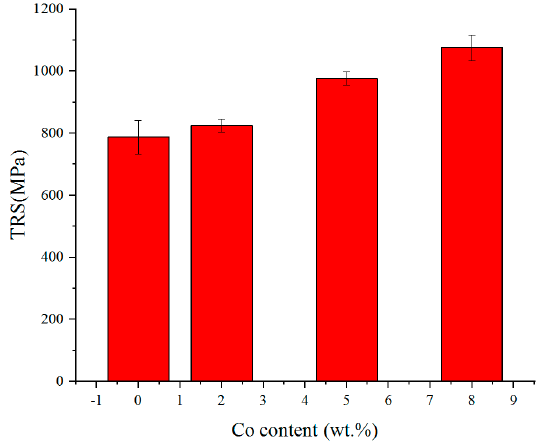
Figure 9. The influence of Co on transverse rupture strength (TRS).